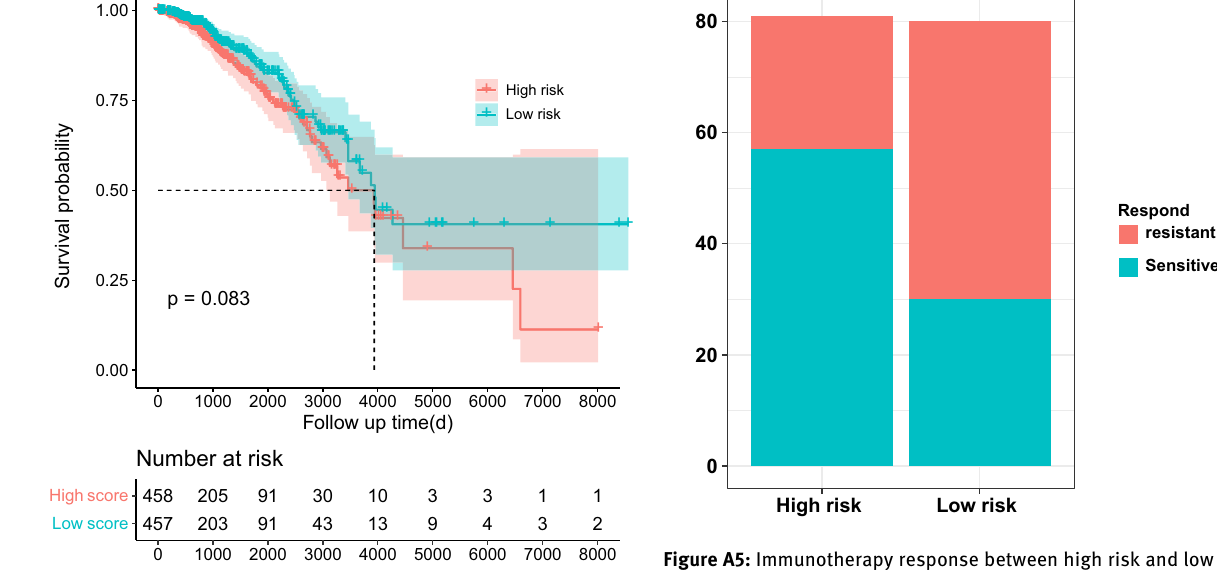
Figure A5: Immunotherapy response between high risk and low risk patients in the TCGA - TNBC